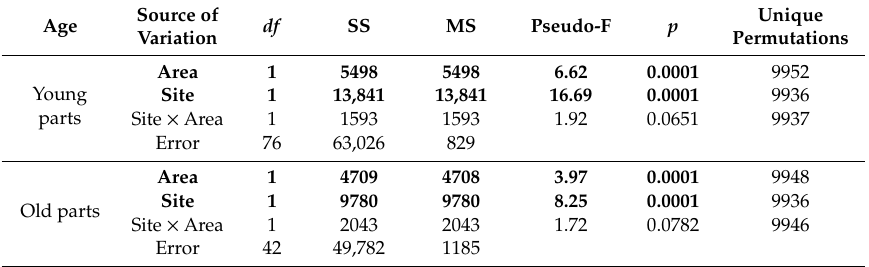
Table 7. E ff ects of plant part size (surface Area of the corresponding part, cm 2 ) and location (Sites K or V) on the multivariate community structure of epibiosis on young and old plant parts of Phycodrys rubens in September 2015: type III sum of squares PERMANOVA for 9999 permutations on fourth root transformed covers of sessile epibionts, Bray-Curtis similarity, frames pooled. Significant terms are highlighted in